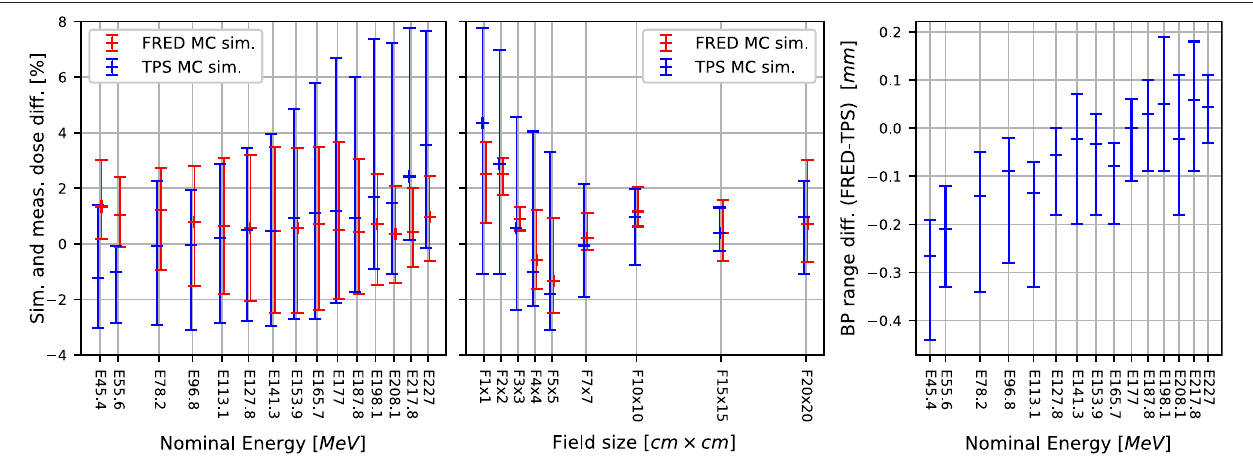
FIGURE6| RelativedifferencesbetweenmeasureddosescalculatedinF RED andtheTPSasafunctionofnominalenergy (leftpanel) and fi eldsize (centerpanel) , aswellasabsoluterange differencesbetweenF RED andtheTPSasafunctionofnominalenergy (right panel) .Eachdatapointrepresentstheaverageoverall fi eldsizes in the left and right panels and over all energies in the center panel. The error bars indicate minimum and maximum values in a group.